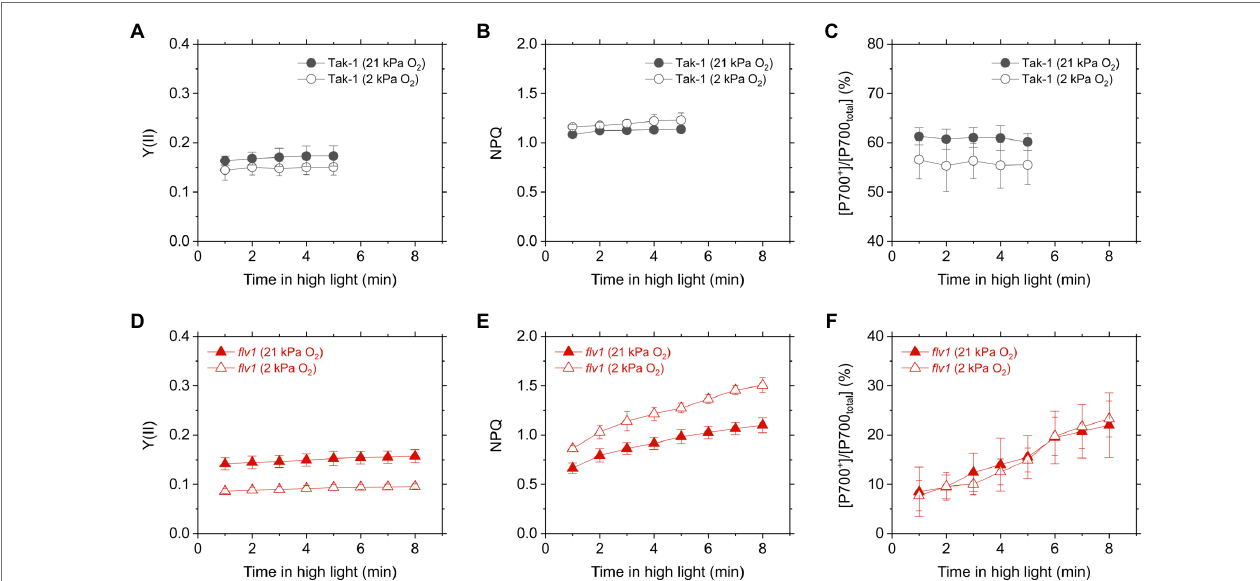
FIGURE 5 | Time-dependent changes of effective quantum yield of PSII, Y(II) (A,D) , NPQ (B,E) , and P700 oxidation (C,F) in high light (760 μ mol photons m − 2 s − 1 ) in the liverwort M. polymorpha (Tak-1; A–C ) and the mutant flv1 (D–F) . Experiments were performed under 21 (closed symbols) and 2 kPa O 2 (open symbols). Data are shown as the mean with the standard deviation ( n = 3, biological replicates).